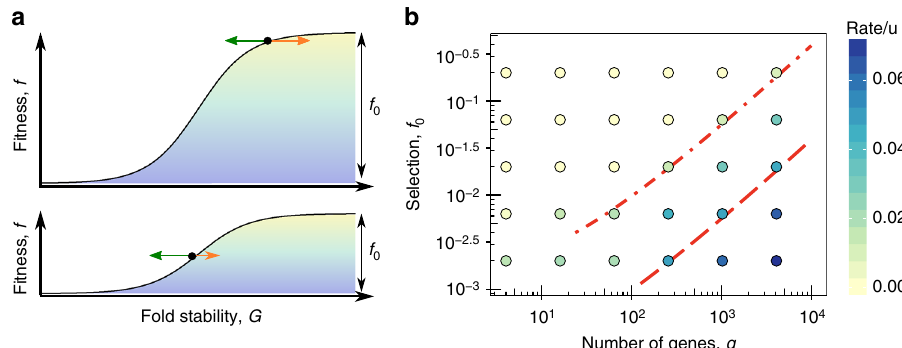
Fig. 4 Gene loss. a The stability-dependent fi tness landscape f ( G ) of Fig. 1a is shown for two values of the selection amplitude f 0 , which is the fi tness difference between functional and dysfunctional proteins. Arrows indicate the effect of deleterious mutations (green) and selection (orange, proportional to f 0 ) on the population mean trait. For strongly selected genes ( f 0 (cid:6) ~ σ , top panel), the mutation-selection dynamics generates stable equilibria; cf. Eqs. 2, 23. For weakly selected genes ( f 0 ≲ ~ σ , lower panel), mutations outweigh selection, leading to signi fi cant gene loss. b Rate of gene loss (indicated by color, in units of u ) as a function of the gene selection coef fi cient, f 0 , and the number of co-evolving genes g . Genes with f 0 (cid:7) ~ σ (long-dashed line, cf. Fig. 2b) have appreciable loss rates; genes with f 0 ≳ 10 ~ σ (dashed-dotted line) have negligible loss rates, i.e., are conserved under phenotypic interference. Other simulation parameters as in Fig. 2; see Methods section for simulation